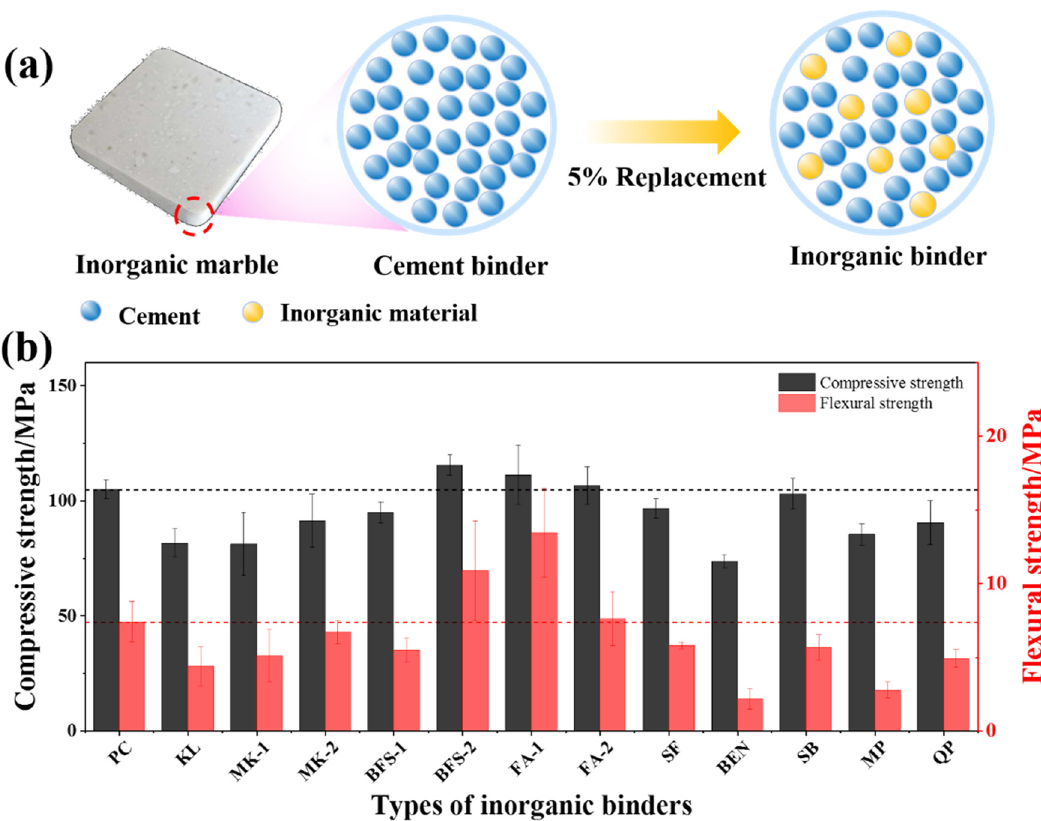
Figure 4: A schematic illustration and mechanical properties of inorganic binders: ( a ) schematic illustration of inorganic binders and ( b ) compressive and fl exural strengths of inorganic